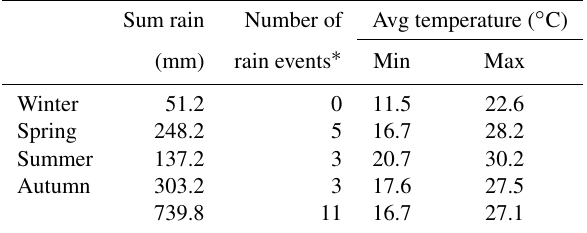
Table 2. Seasonal and cumulative rain, number of rain events and seasonal and annual averages of minimum and maximum tempera- tures of the experimental